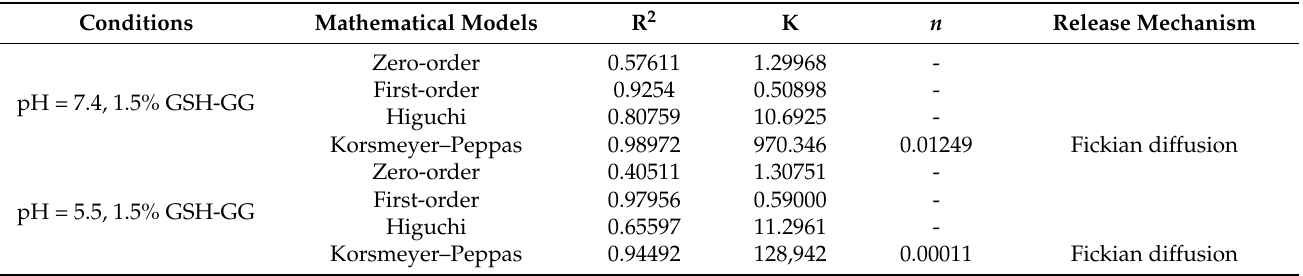
Table 1. Determination of kinetic parameters and mechanism of DOX released by 1.5% ( w / v ) GSH-GG (pH = 7.4 and pH =